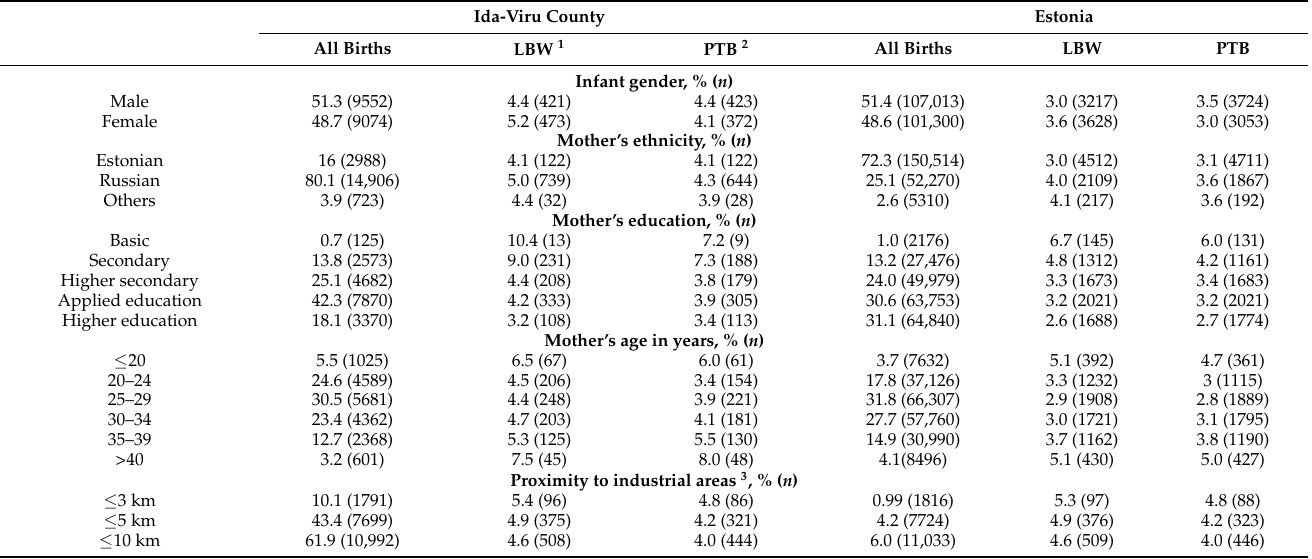
Table 1. Prevalence of adverse birth outcomes and distribution across the sociodemographic and spatial metrics in Ida-Viru County and Estonia among singleton babies born in